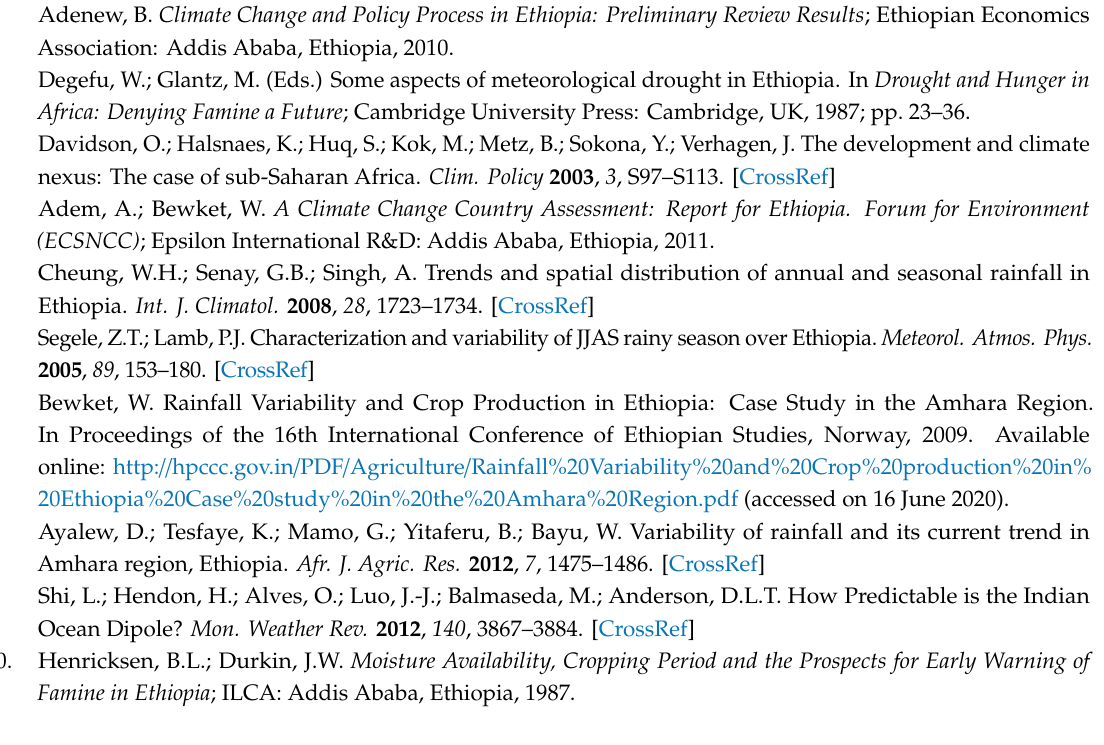
Figure A2. ( a ) Scatterplot of elevation vs. Jul.–Oct. surface T across Ethiopia, arrow highlights the most suitable range, ( b ) main crop-growing areas (green shaded). ( c ) Example of LGP constraints imposed by thresholds of daily soil moisture and minimum T. Note the drought in 2015 and higher T in 2017–2018. The min. T is trimmed above 16C to indicate no threshold exceedance.